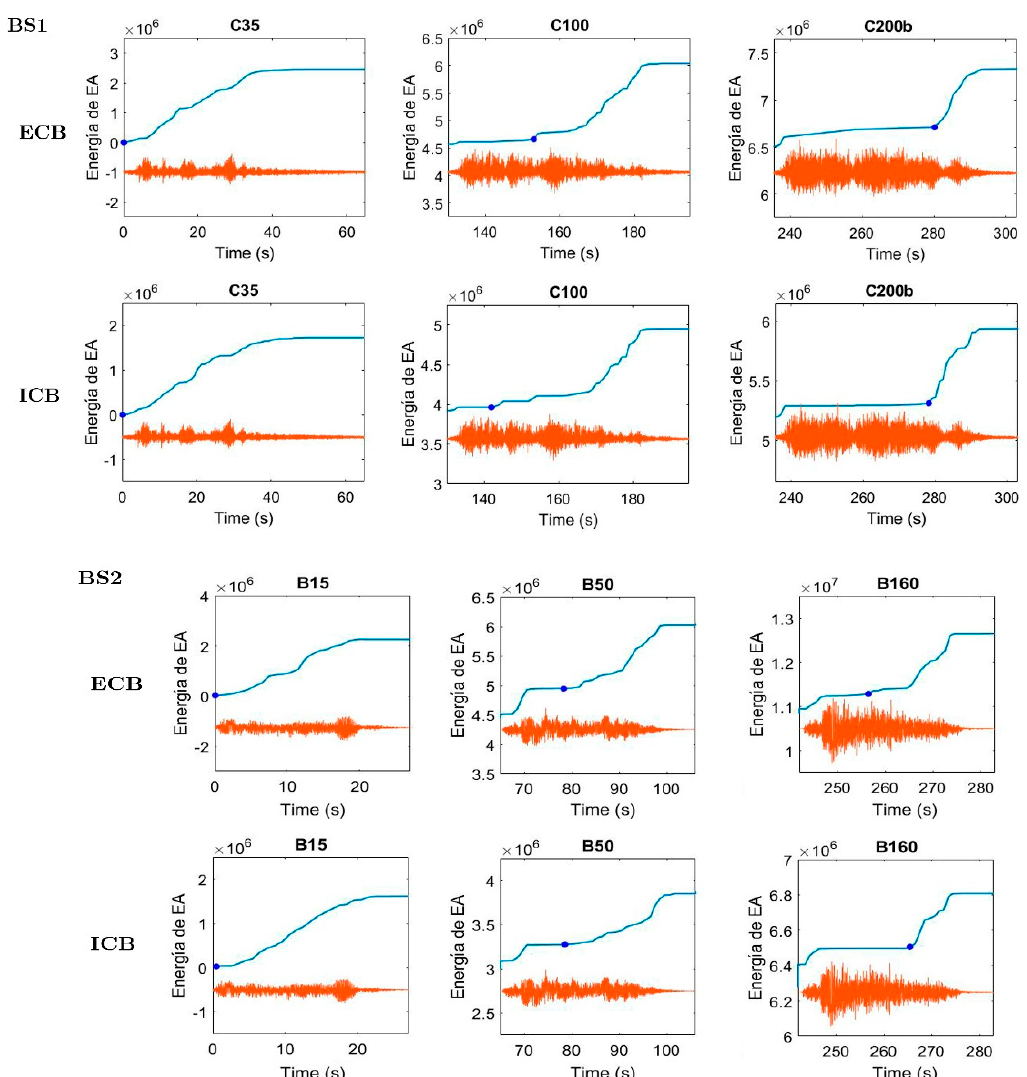
Figure 13. The accumulated AE energy on 3 different seismic simulations with the beginning of the AE SIGN , t AE .